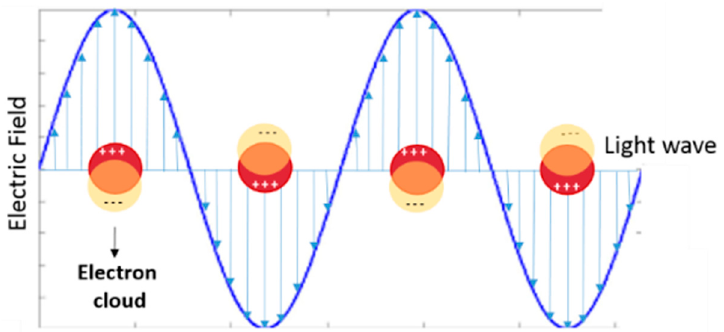
Figure 1. Graphical illustration of localized surface plasmon resonance (LSPR) band formation (in yellow circle the negative electron cloud, in red circle the positive electron cloud).